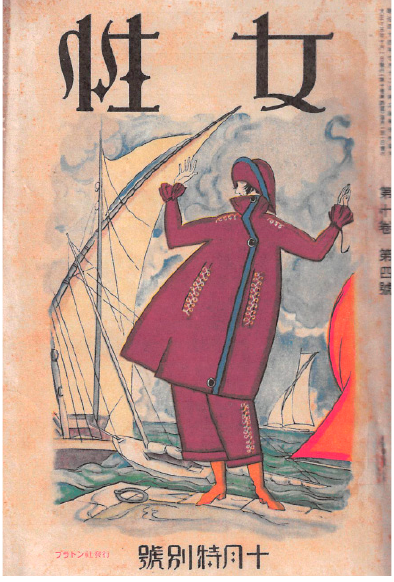
Figure 4. The cover of the October 1926 issue of Josei magazine.